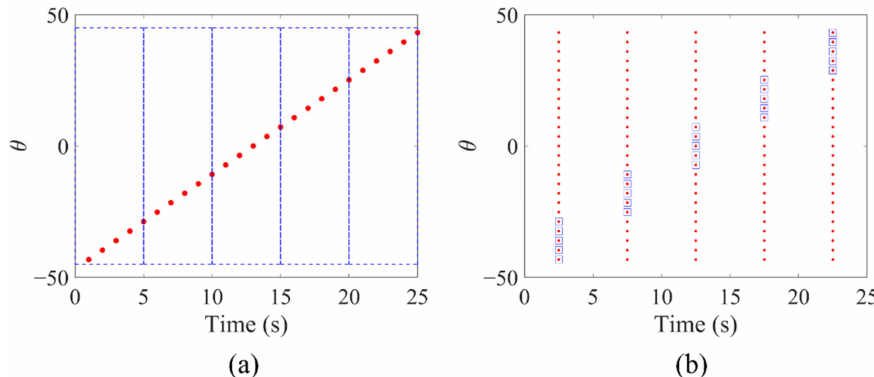
Figure 3. The time-resolved PPI scans with azimuth angle change from − 45 ◦ to 45 ◦ with sampling frequency of 1 Hz. As shown in ( a ), the scanning points (red points) are within each 5 s time interval (blue dashed line). If the temporal resolution for wind retrieval is selected as 5 s, then the scanning points will be aligned to different time window as shown in ( b ). Each frame only has 5 scans available for wind retrieval.